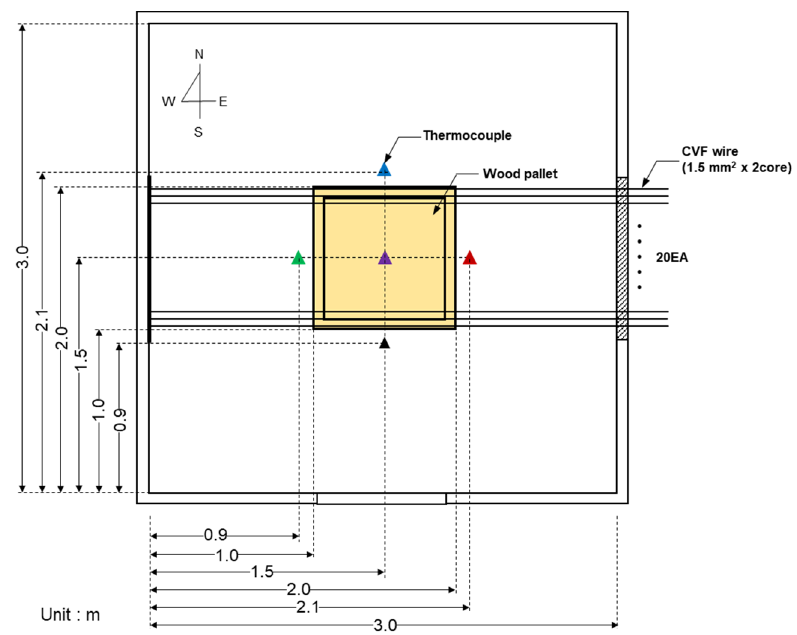
Figure 2. Internal configuration of the test room (top view): thermocouple installed in the east, west, south, north, and center, and wood pallet installed in the center.